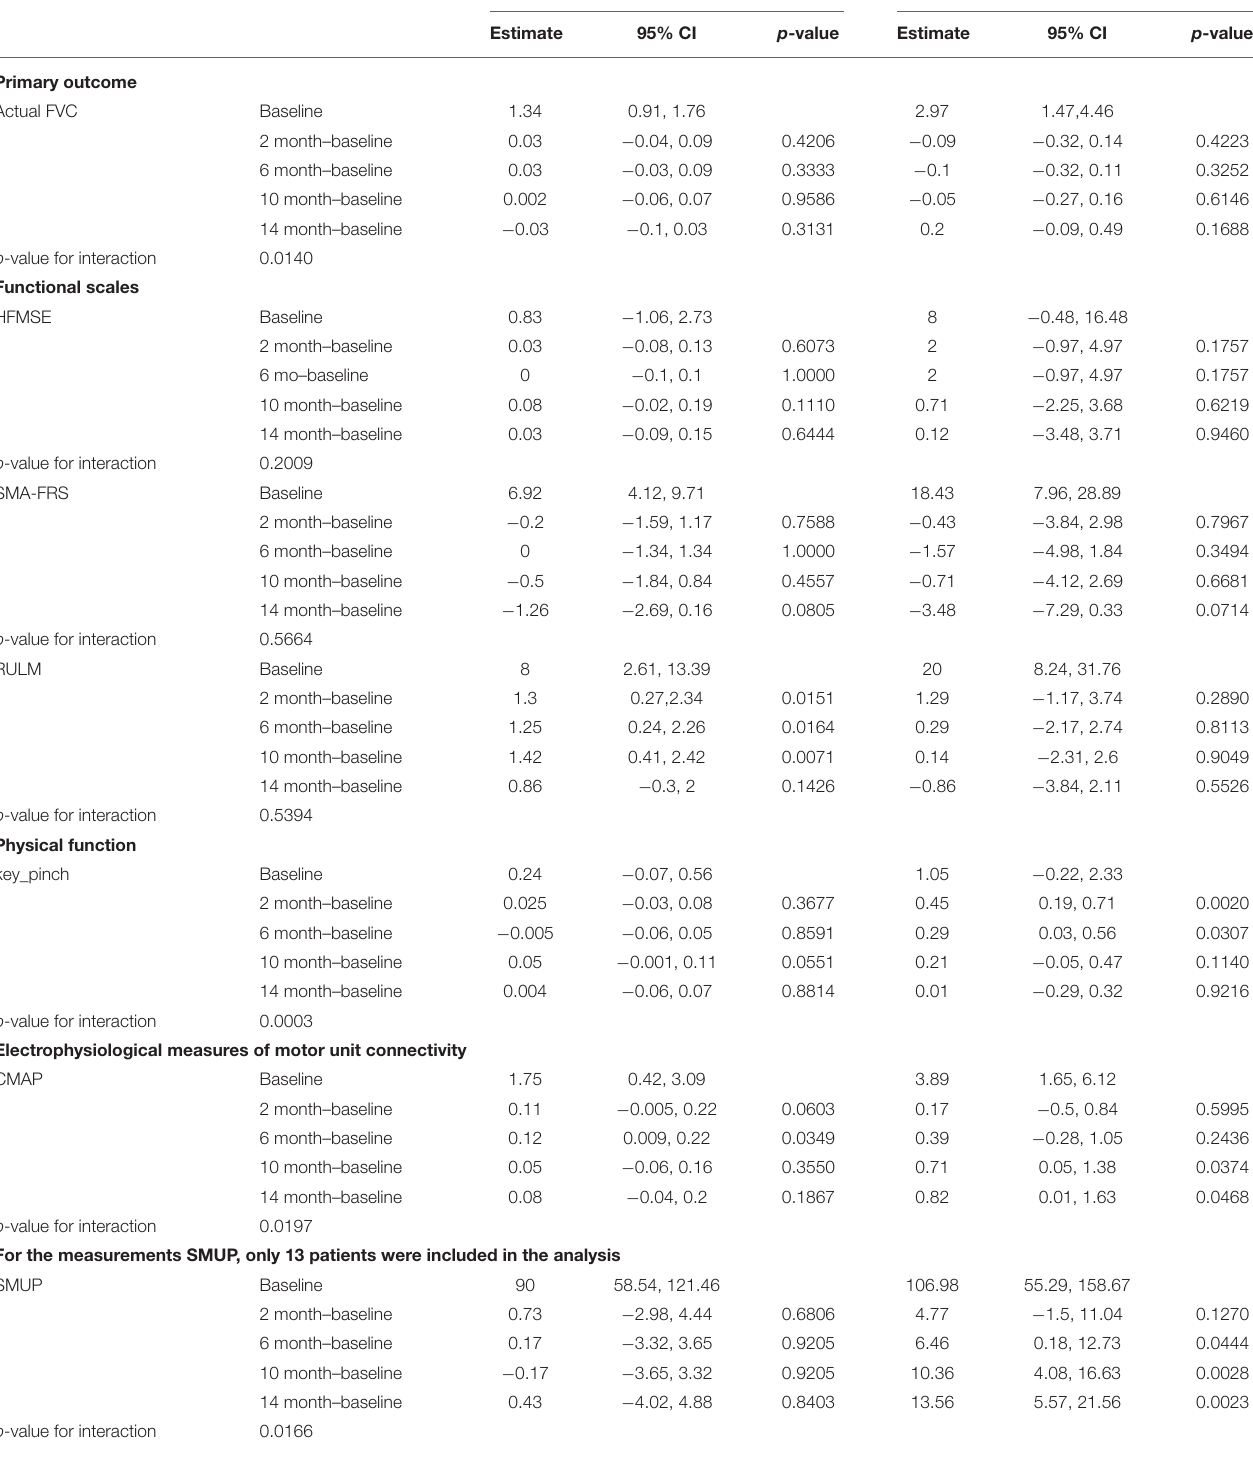
TABLE 5 | Longitudinal change of outcomes stratified by cervical or lumbar. Measure Time Cervical Lumbar Estimate 95% CI p -value Estimate 95% CI p